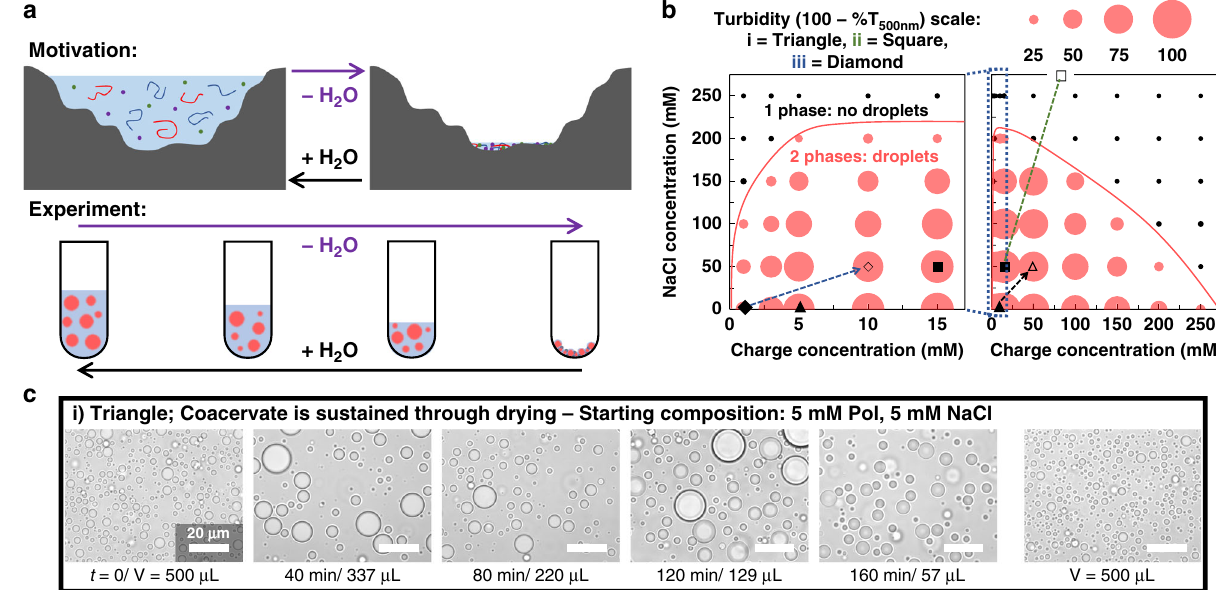
ii) Square; Coacervate disappears with drying – Starting composition: 15 mM Pol, 50 mM